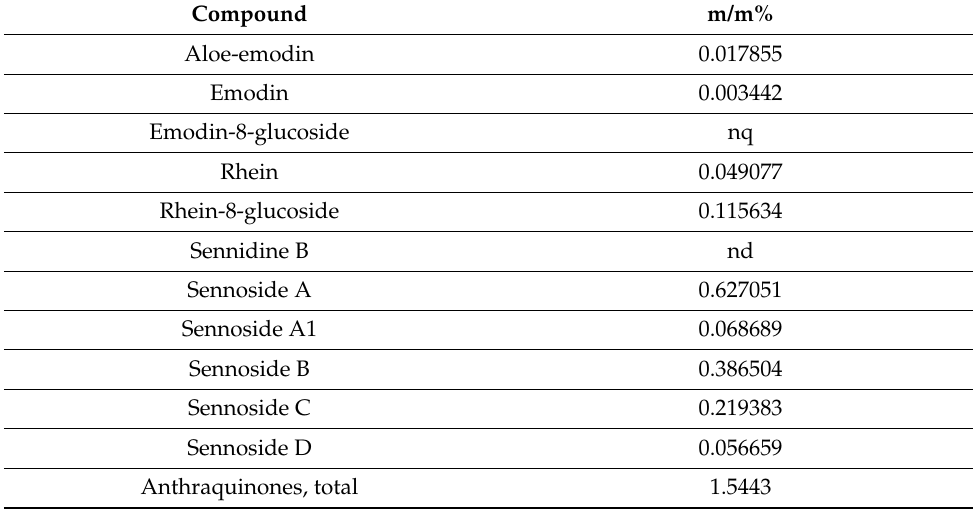
Table 2. Anthraquinone content of SMD tablets expressed as m/m% (i.e., (mass of a single compo- nent/total mass) ×